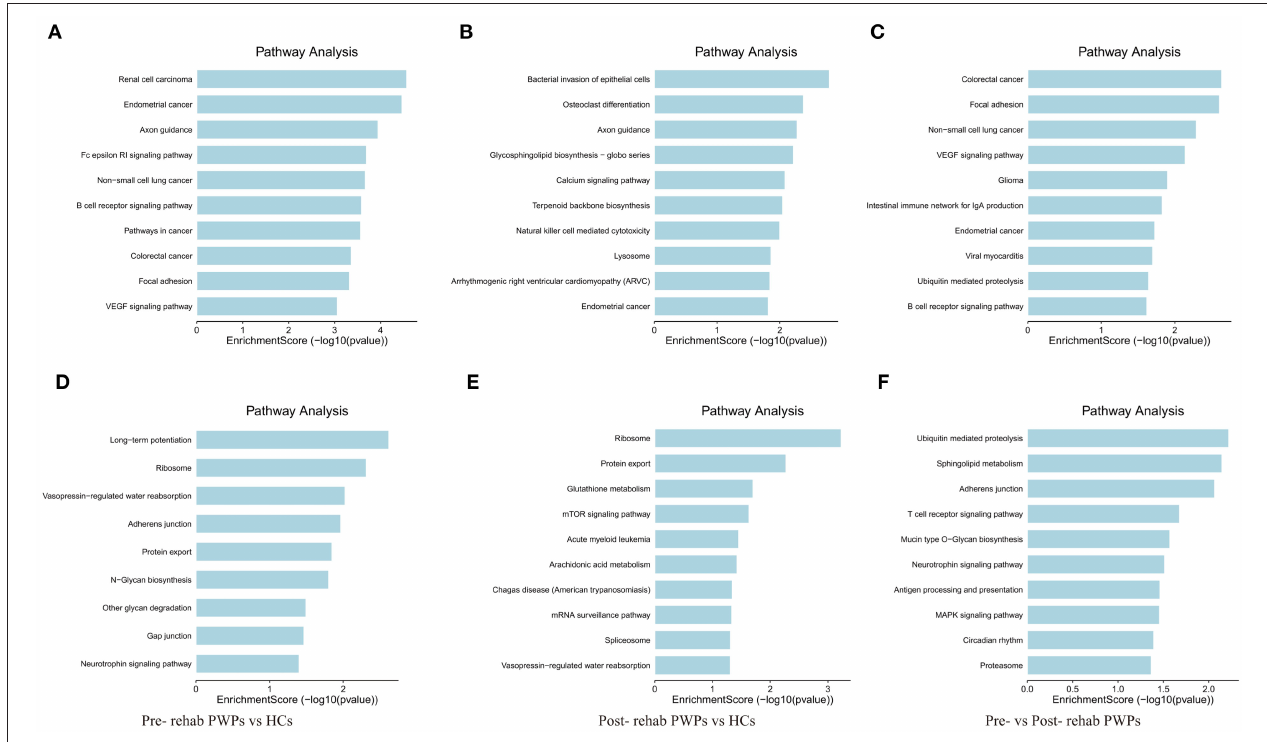
FIGURE 5 | KEGG pathway analysis of differentially expressed genes. KEGG pathway analysis of upregulated (A) and downregulated (D) mRNAs between pre-rehab PWPs and HCs. KEGG pathway analysis of upregulated (B) and downregulated (E) mRNAs between pre-rehab PWPs and HCs. KEGG pathway analysis of upregulated (C) and downregulated (F) mRNAs between pre- and post-rehab PWPs. Pre-rehab, pre-rehabilitation; post-rehab, post-rehabilitation; PWPs, patients with Parkinson’s disease; KEGG, Kyoto Encyclopedia of Genes and